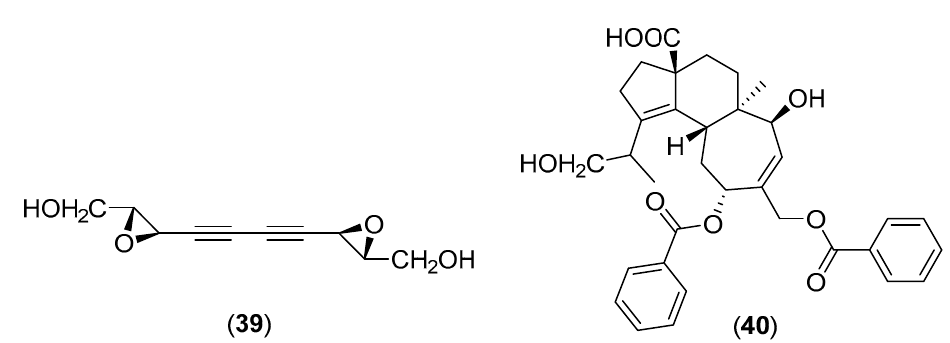
Figure 8. Chemical structures of selected compounds isolated from Hydnum repandum.